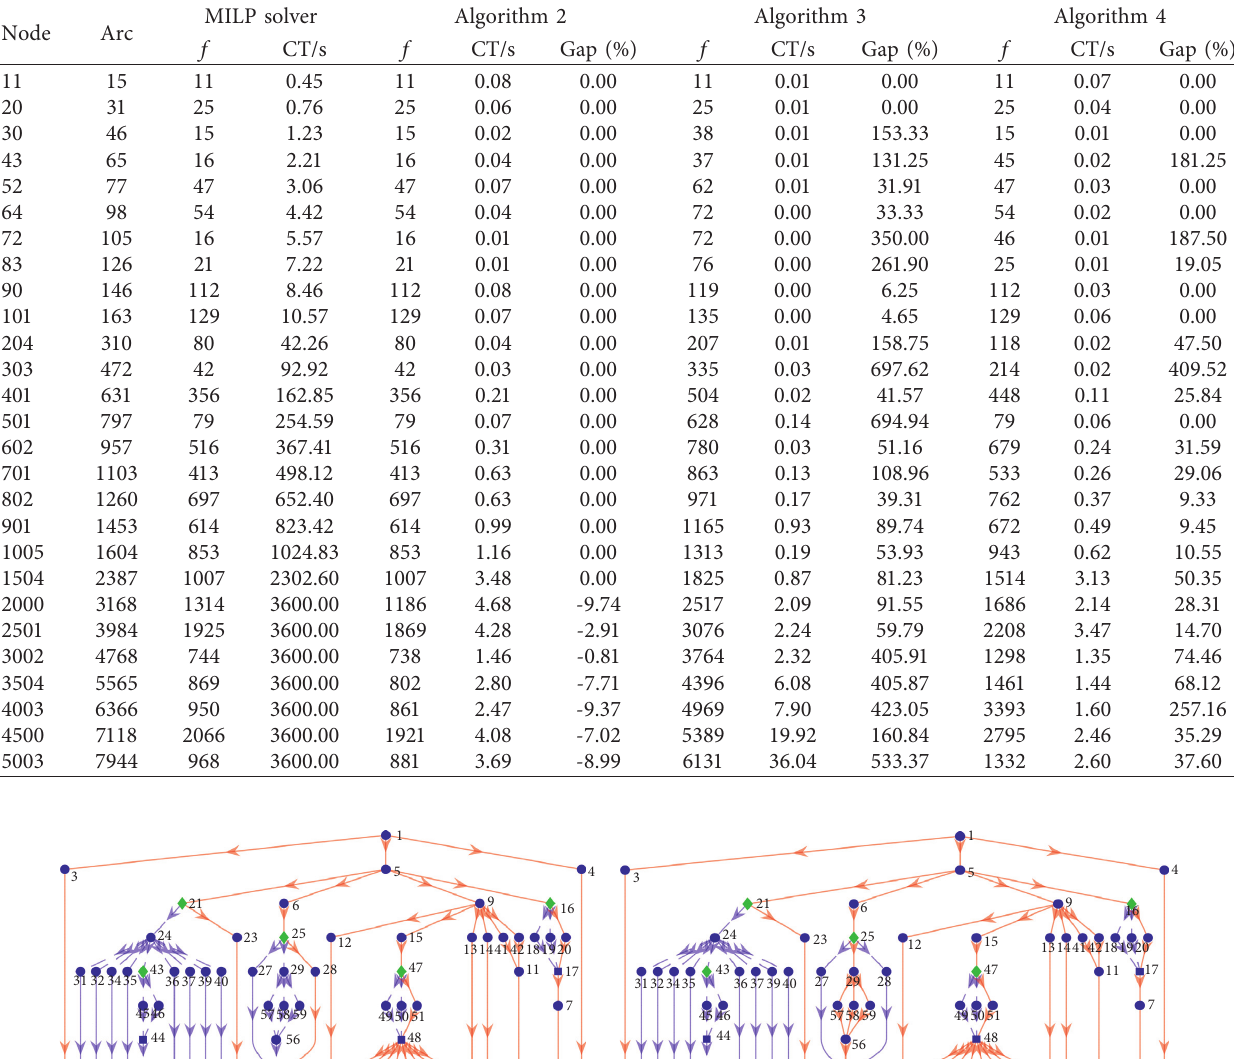
Table 2: Comparison between different algorithms.